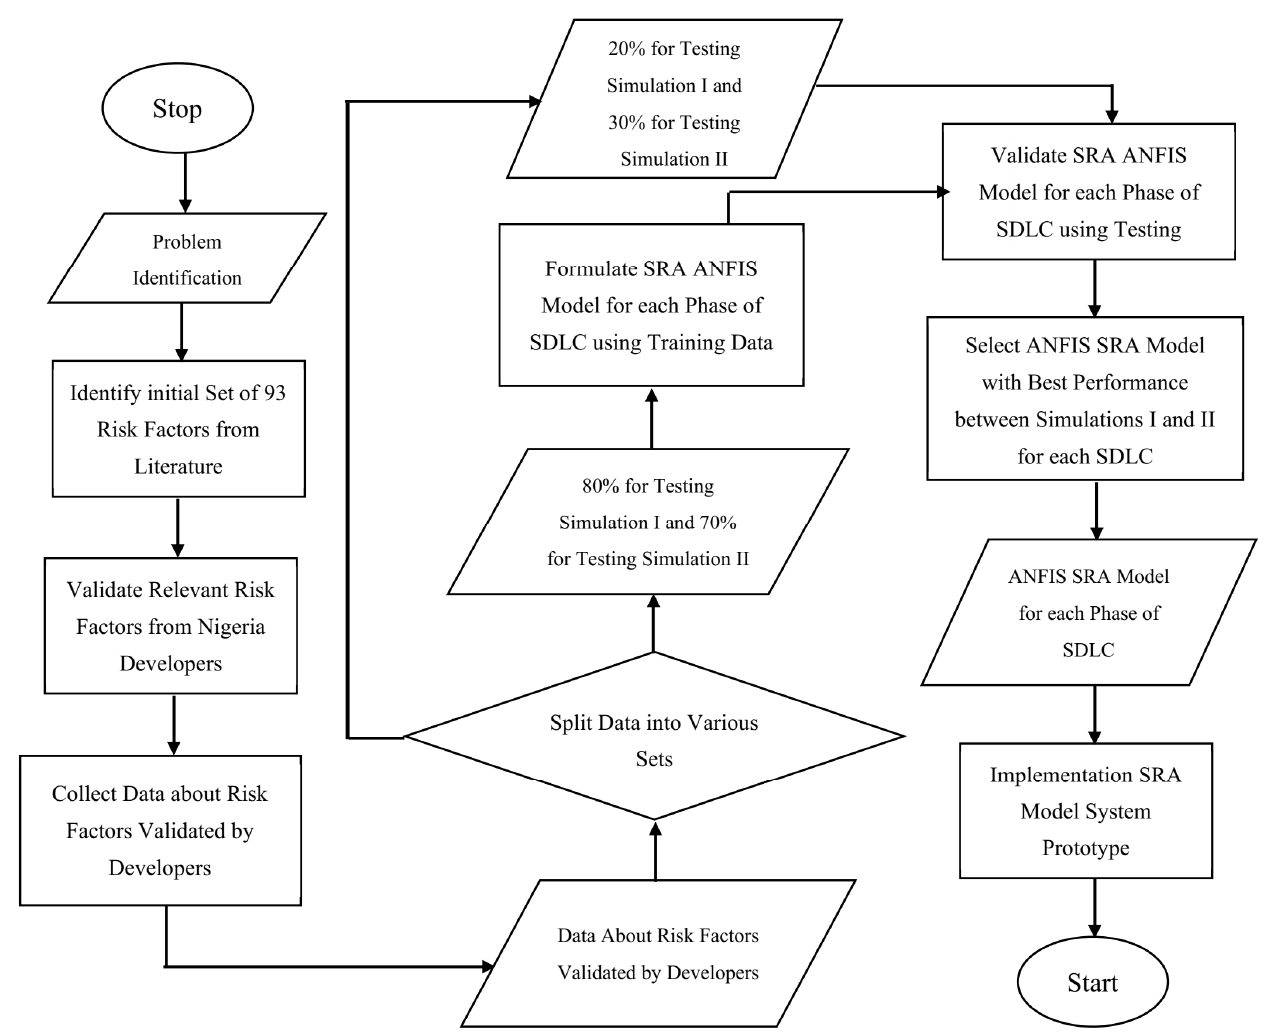
Figure 4. Research Methodology Process.